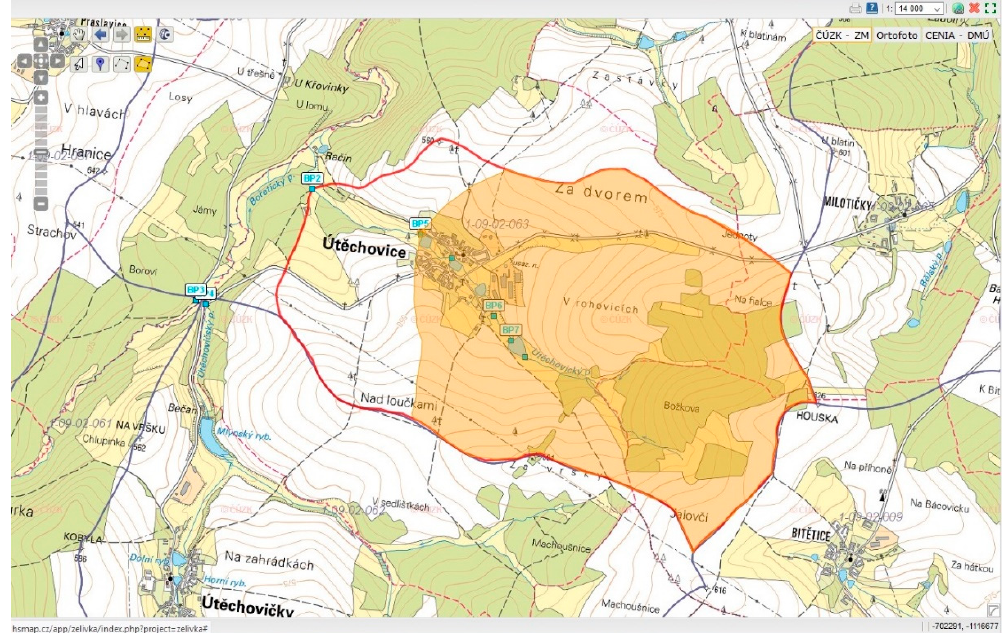
Figure 1. Boundaries of BP2 and BP5 profiles made in BNHelp geographical information system (GIS) application.